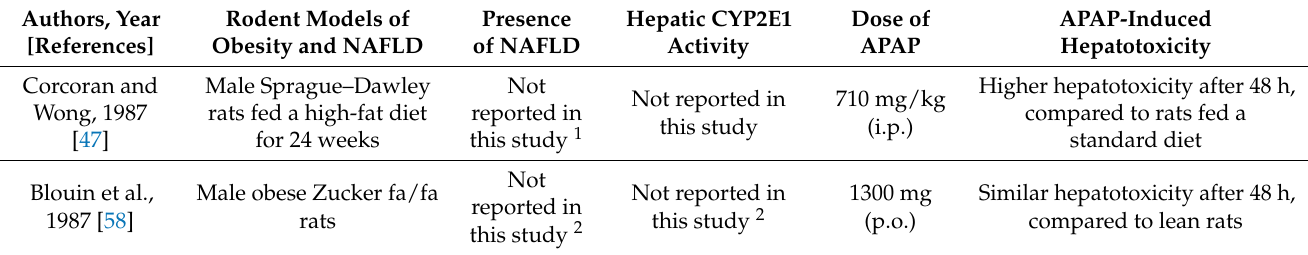
Table 2. Summary of the rodent studies (ordered by increasing year) carried out on APAP-induced hepatotoxicity in obesity and